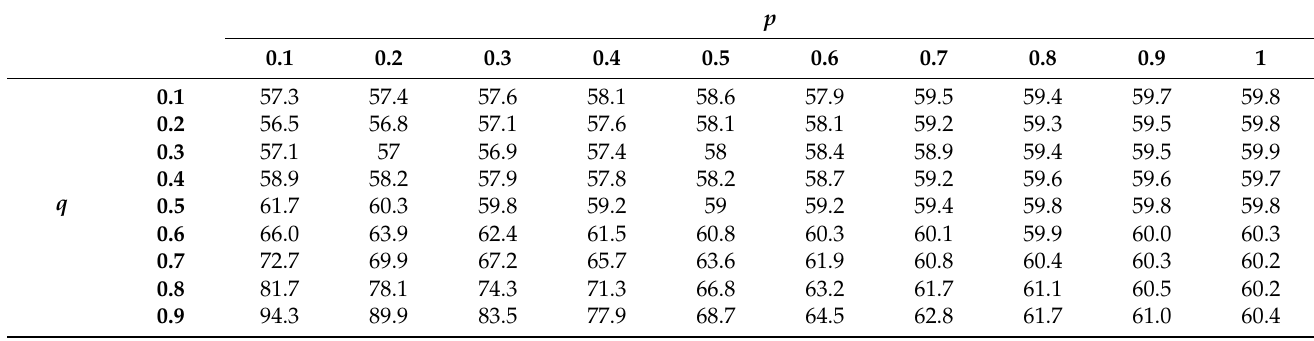
Figure 7. Availability of the total system for different q and p . Graphic representation. Table 12 and Figure 8 show the O & M costs for different q and p values, considering the cost structure described in Section 2.4 and the results of sojourn times and of number of triggers obtained from PN model. Comparing the results from Table 11 with Table 12, it is concluded that the greater the availability, the greater the operation and maintenance costs. Table 12. O & M costs for different q and p (in MEUR). Matrix representation.